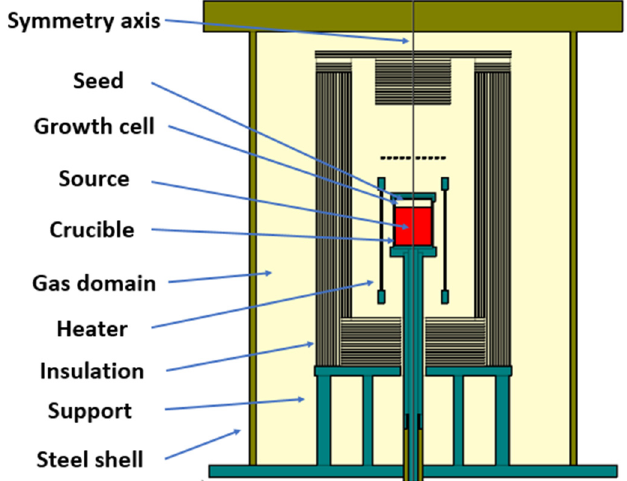
Figure 1. Structure of AlN single crystal growth furnace.